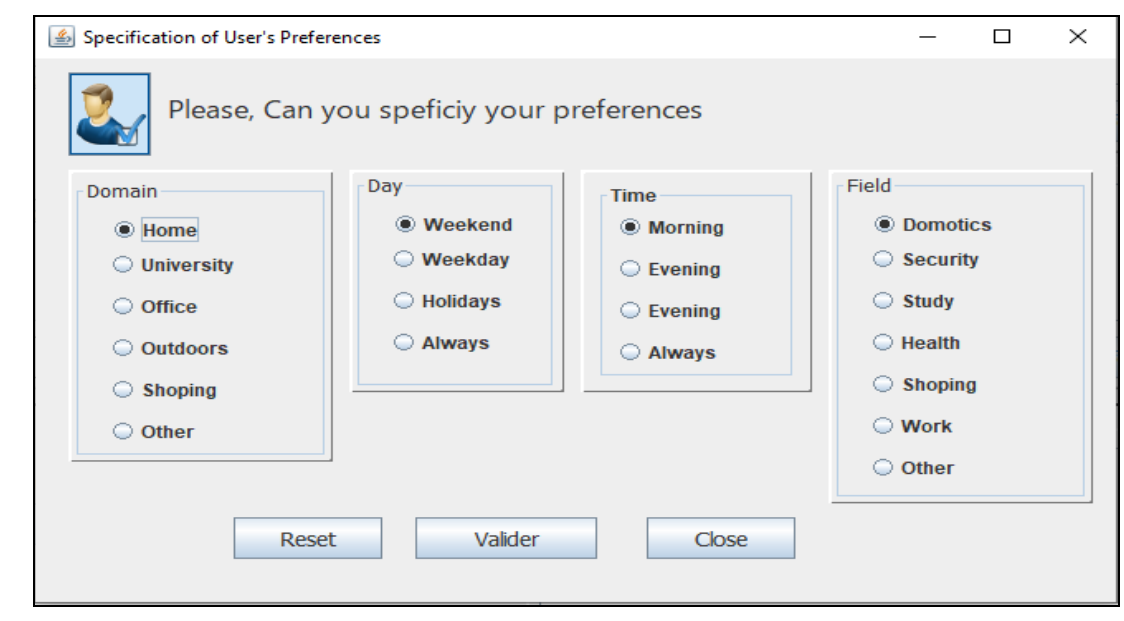
Figure 6. GUI for specifying the values of preferences.